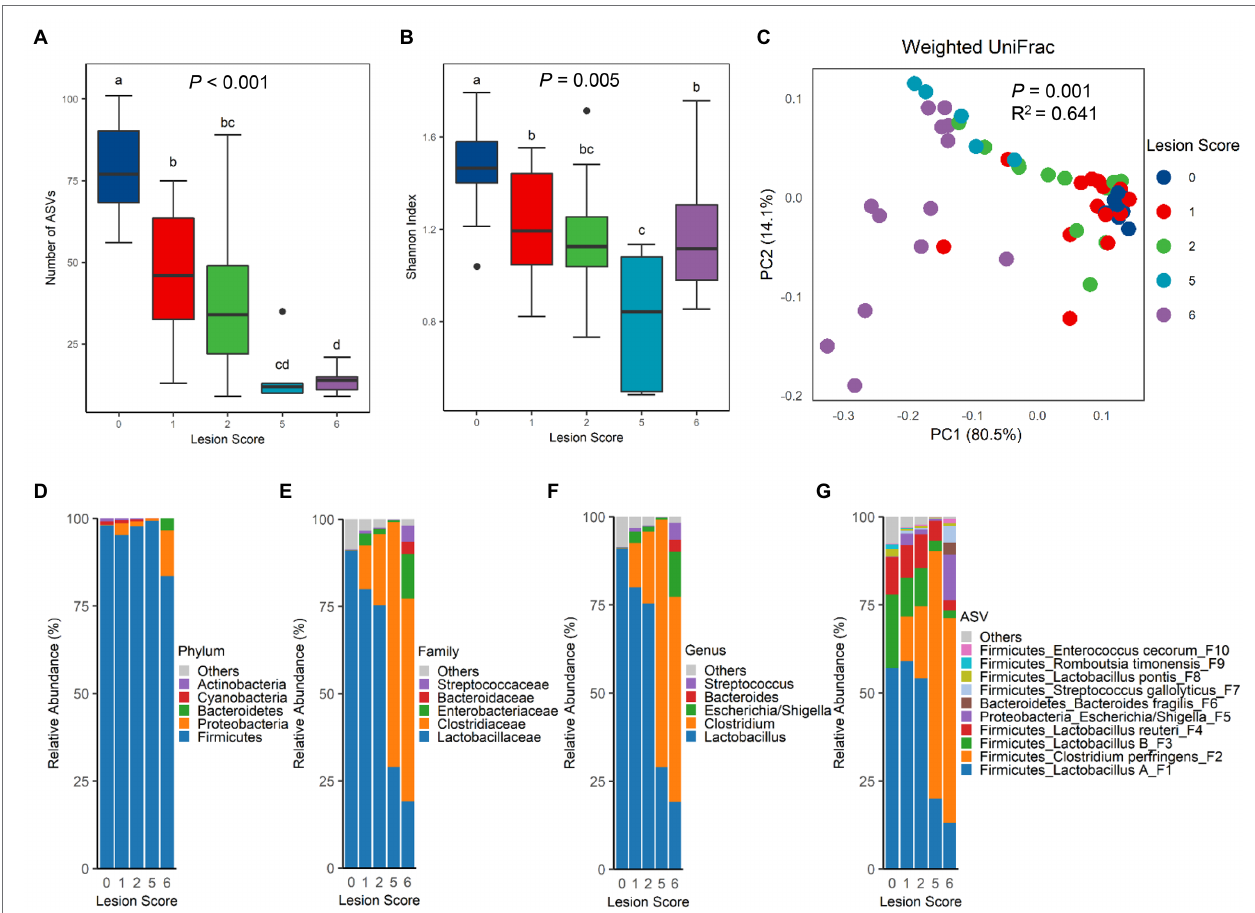
FIGURE 2 | Diversity and composition of the ileal microbiota among chickens with varying severities of NE. A group of 90 male Cobb broilers were subjected to NE, while another 10 chickens in the control group were mock-infected. Animals were divided into five groups based on lesion scores. The number of observed amplicon sequence variants (ASVs; A ) and Shannon index (B) of the ileal microbiome were estimated and visualized using box and whisker plots. Each box indicates median, 25 and 75th percentiles, while whiskers extend to 1.5 interquartile range. Significance was measured using the Kruskal-Wallis test, and pairwise comparisons were implemented using the Wilcoxon rank sum test. Different superscripts denote significance ( p < 0.05) in pairwise comparisons. (C) Principal coordinates analysis (PCoA) plots of weighted UniFrac distances. Significance was determined using permutational multivariate ANOVA (PERMANOVA). Relative abundances of top five phyla (D) , top five families (E) , top five genera (F) , and top 10 ASVs (G) in the ileal microbiota were